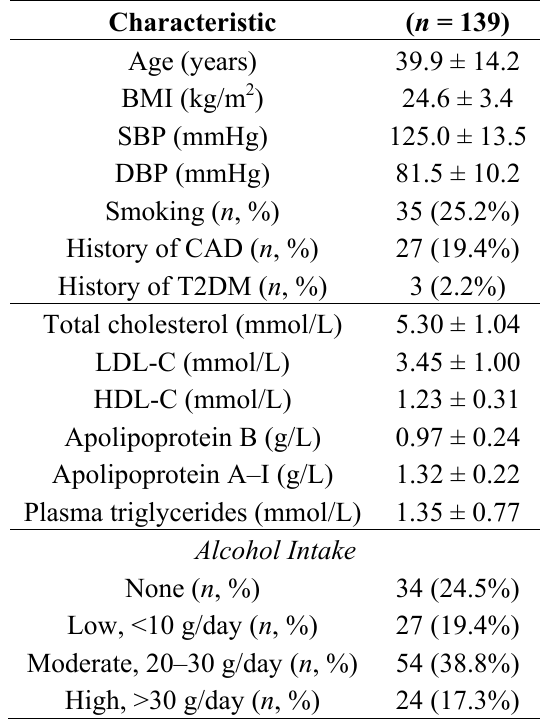
Table 1. Clinical and biochemical characteristics of the 139 participants to the